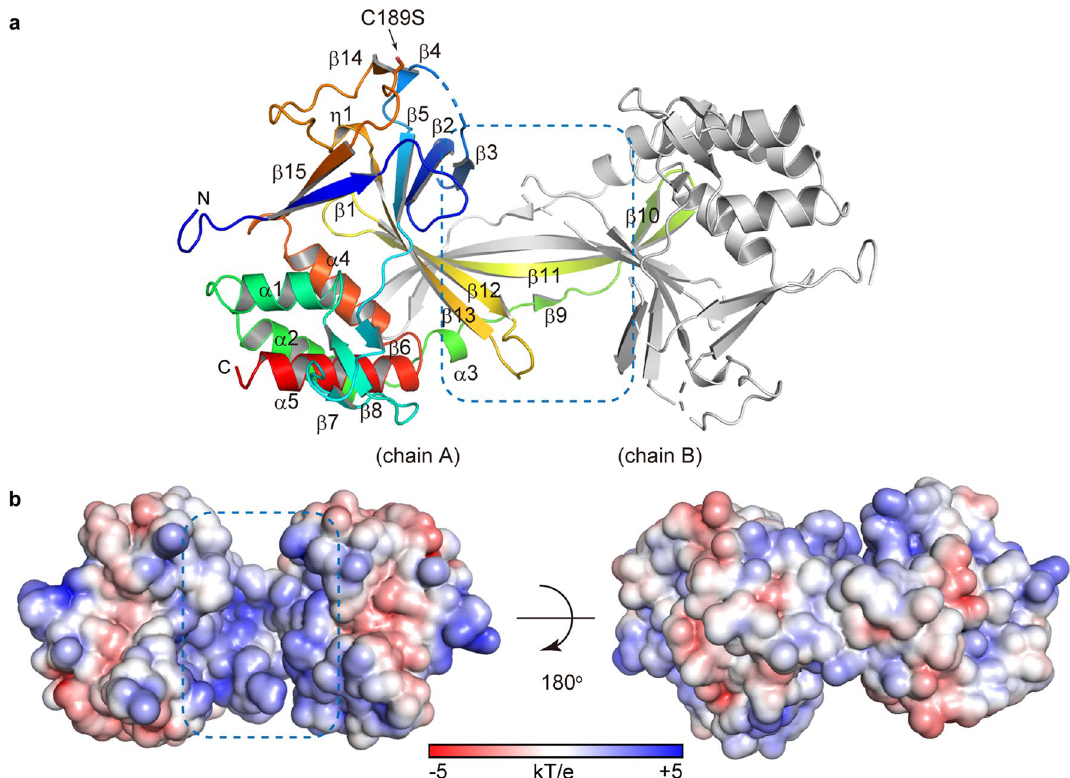
(chain B) is colored gray. The HALFPIPE region of R.CcoLI dimer is indicated by a blue dotted square. The side chain of C189S is shown by a stick model. ( b ) The ± 5 kT/e electrostatic potential of the R.CcoLI dimer is plotted on the solvent-accessible